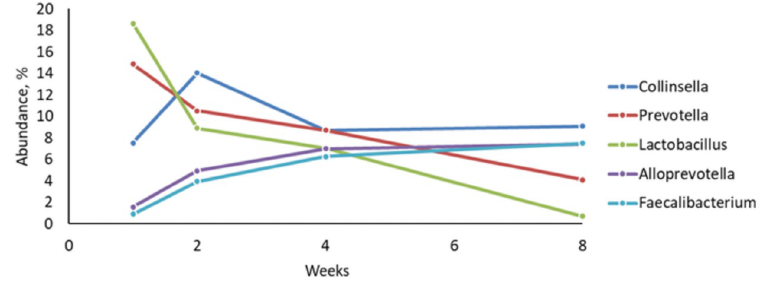
Fig 4. Changes in relative abundance of dominant bacterial genera over time in dairy calves’ feces fed milk replacer supplemented or not with β